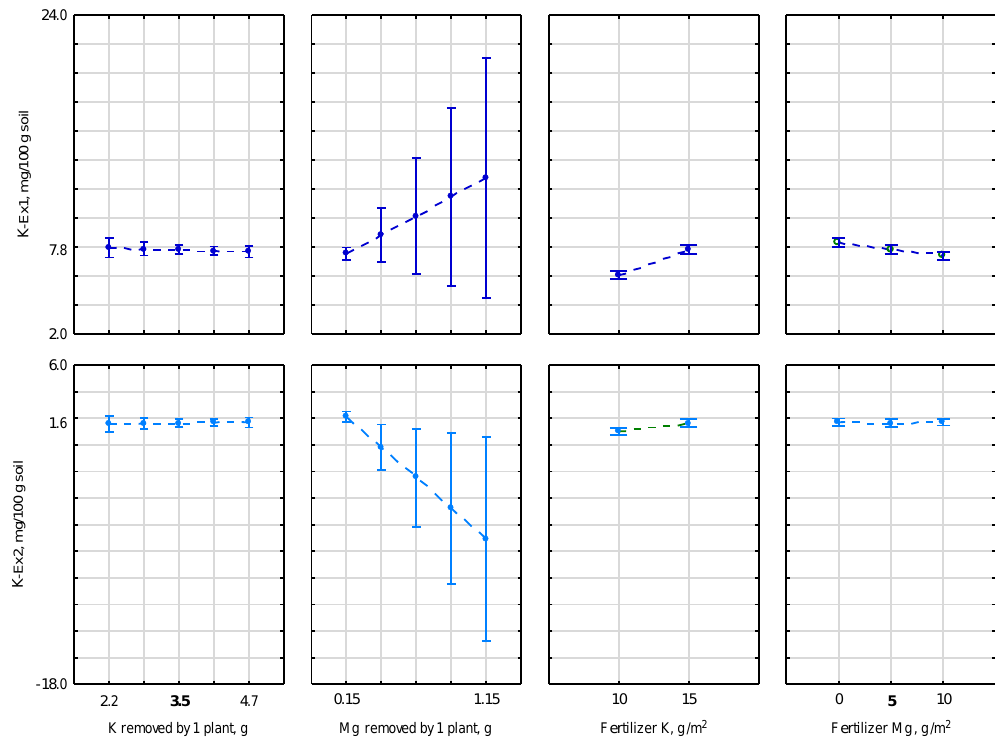
Figure 3. Profiles for predicted values of soil exchangeable K according to the GLM model (R 2 = 0.87 for K-Ex1 and R 2 = 0.58 for K-Ex2). Abbreviations: K-Ex1 and K-Ex2 — soil exchangeable K extracted by 1 M CH 3 COONH 4 and 0.0025 M CaCl2, respectively. Whiskers denote confidence intervals.